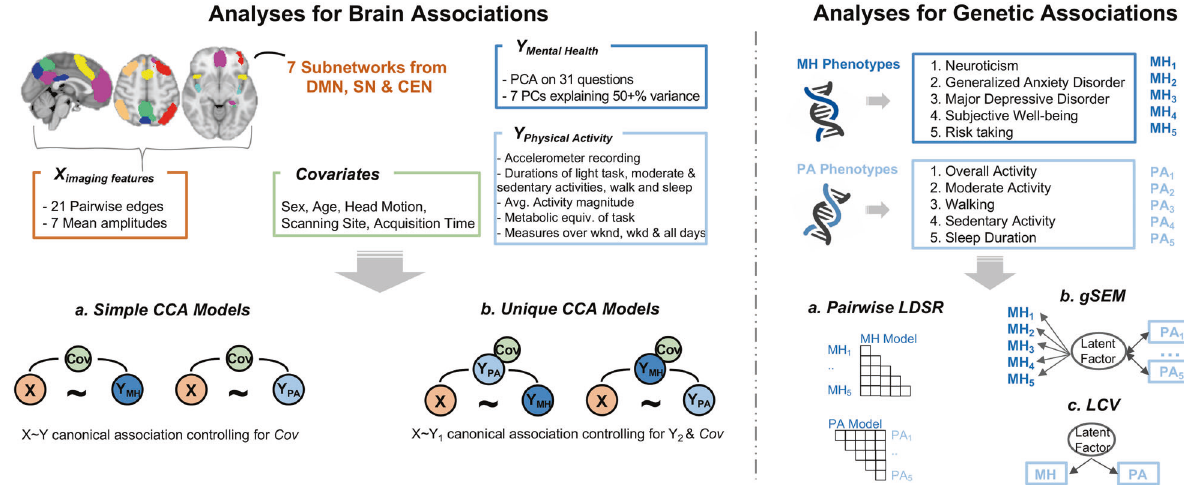
Fig. 1 Overview of variables and analyses. Separate analyses were conducted for brain (left panel) and genetic associations (right panel). For brain associations, canonical correlation analysis (CCA) was employed for mental health (MH), and physical activity (PA) separately. Simple and unique CCA models only differed in whether the shared variance between MH and PA was accounted for. For genetic associations, GWAS summary statistics for fi ve mental health phenotypes (MHP 1 -MHP 5 ) and for fi ve physical activity phenotypes (PAP 1 – PAP 5 ) were leveraged into pairwise linkage disequilibrium score regression (LDSR) analyses, in MHP and PAP models separately. Genomic structural equation modeling (gSEM) was also employed to identify genetic associations between a latent factor from MH phenotypes and each PA phenotype, followed by a latent causal variable analysis (LCV) that allows for inferring causal genetic relationships among MH and PA